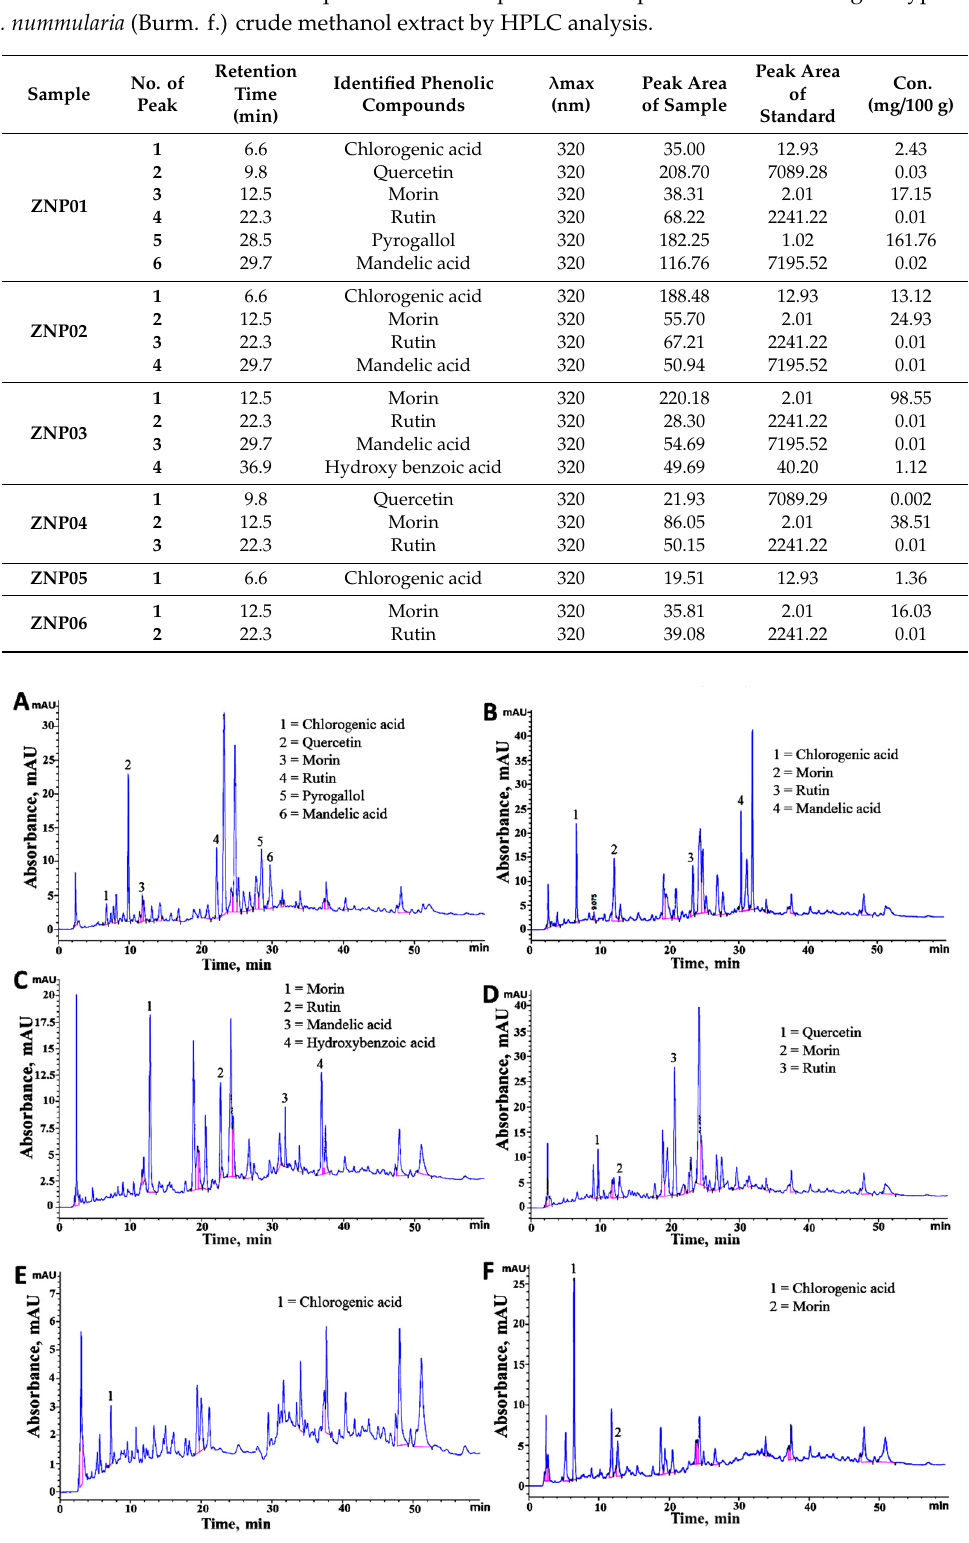
Figure 3. HPLC-UV chromatograms of di ff erent genotype of Z. nummularia : ( A ) ZNP01, ( B ) ZNP02, ( C ) ZNP03, ( D ) ZNP04, ( E ) ZNP05, and ( F )